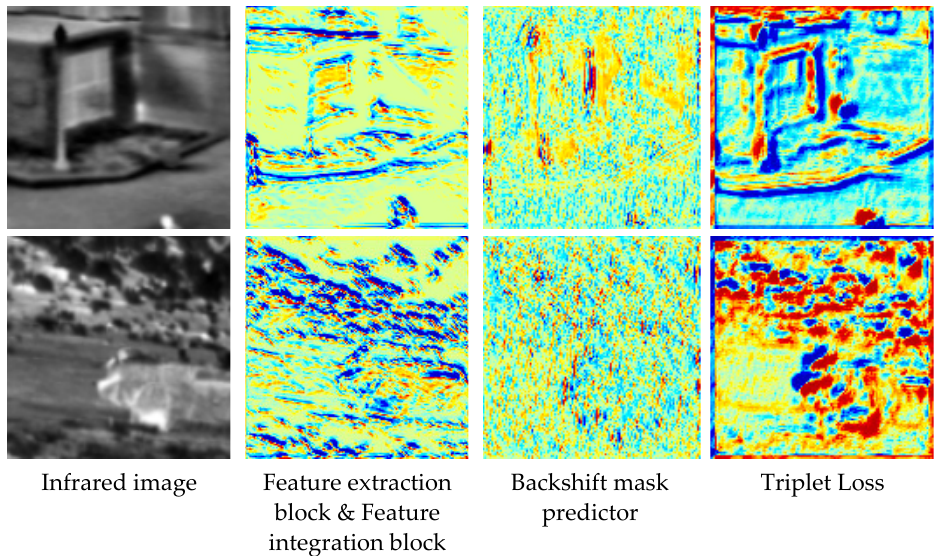
Figure 11. Ablation experiments on the effectiveness of our feature refinement block. Column 1 is the infrared image of the input to our network. Column 2 is a visualization of the attention maps in the “Feature extraction block & Feature integration block” framework. Column 3 is a visualization of the attention map in the “Backshift mask predictor” framework. Column 4 is a visualization of the attention map in the “Triplet Loss” [40] framework.